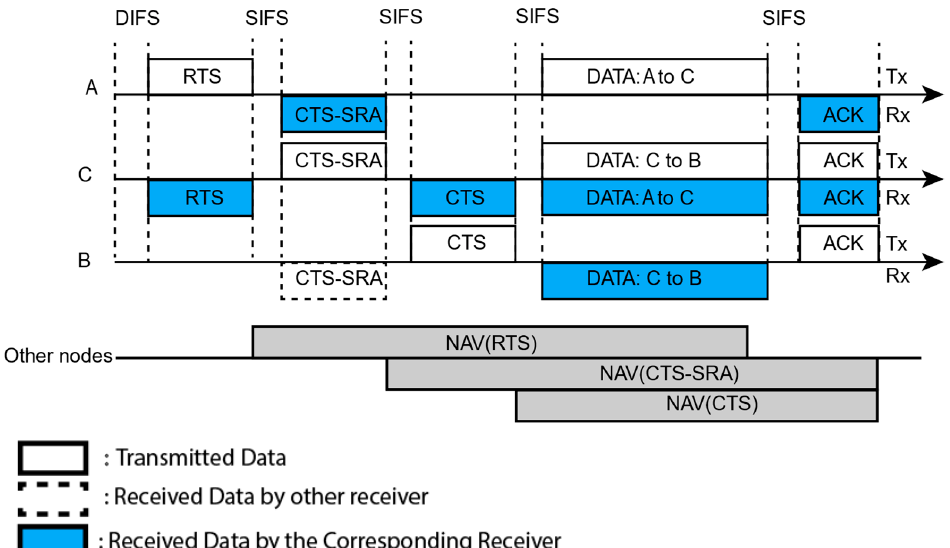
Figure 7. Time sequence of the proposed MAC for destination-based TNFD (the rest of the nodes except MS initiate the transmission).